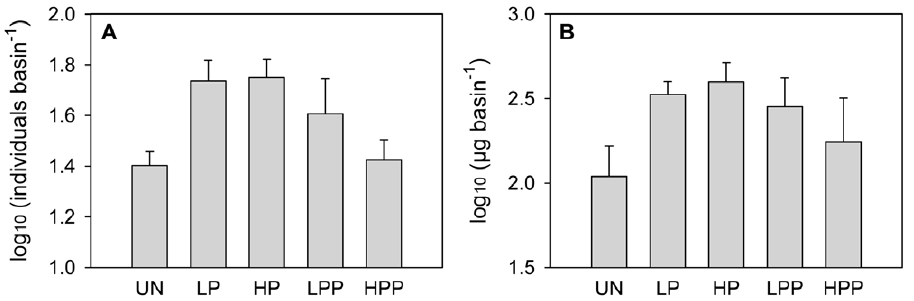
Figure 4. Final copepod abundance (A) and dry weight (B). Only those basins to which the predator had access were considered for calculations. Values are means 6 SE (n=3).